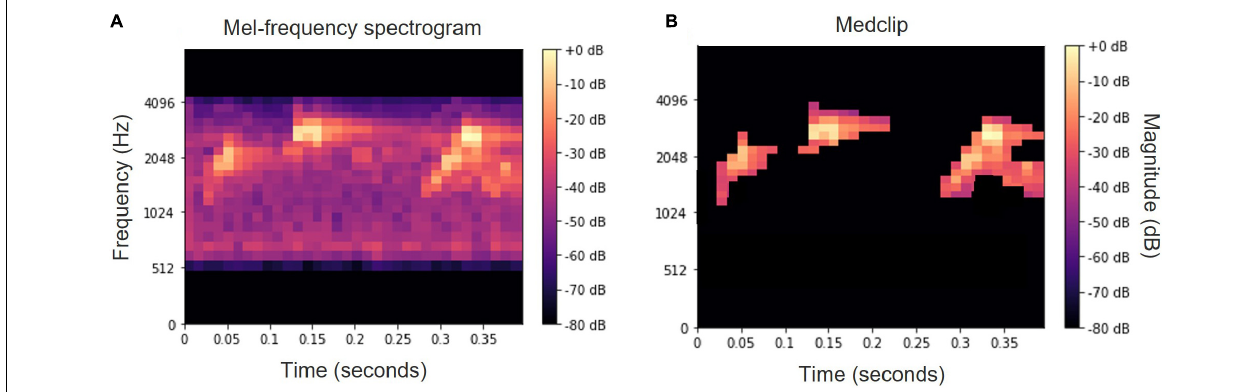
FIGURE 6 | Mel-spectrogram of the word “ tu ti tuyu ” before (A) and after (B) median clipping and small object removal.